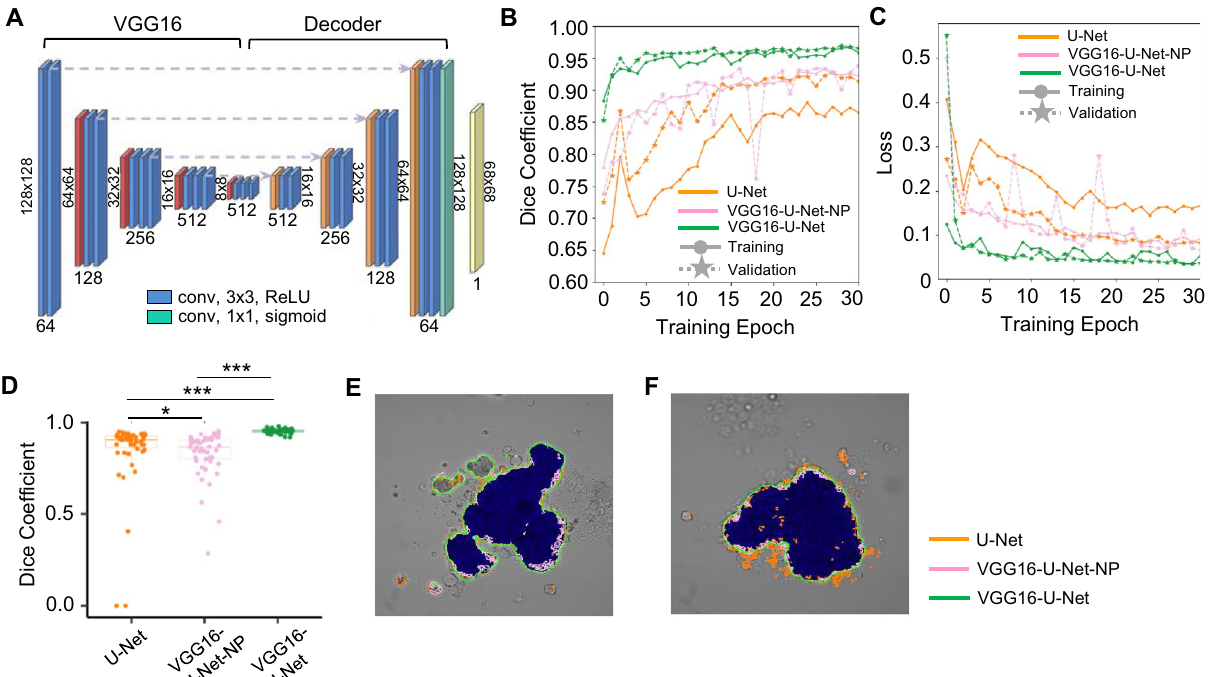
Figure 4. VGG16-U-Net-based image segmentation of VSMC spheroid morphology. ( A ) VGG16-U- Net structure. The training and validation curves of the Dice coefficient ( B ) and the loss function ( C ). ( D ) Comparison of the Dice coefficients among U-Net, VGG16-U-Net-NP, and VGG16-U-Net. * p = 0.015 and *** p < 10 –14 . The p-value was calculated by the Wilcoxon rank sum test. ( E , F ) The edges of the spheroid images were identified by U-Net, VGG16-U-Net-NP, and VGG16-U-Net. The blue regions represent the manually labeled ground-truth community detection algorithm, to produce the clustering outcomes of different numbers of clusters in the training set. We calculated the quality of each clustering result by evaluating the silhouette value, which is a measure of how similar the morphology of a given spheroid is to its own cluster compared to other clusters. We chose four as the number of clusters based on the maximum silhouette values for the number of nearest samples (Fig. 5B). Then, we performed the same clustering analysis for the testing set using the same number of clusters. The silhouette plot of the final clustering analysis showed the least overlap between clusters and mostly positive silhouette values (Fig. 5C). The distribution of spheroid morphologies in each cluster is displayed on a UMAP plot (Fig. 5D), and the proportion of spheroids in each cluster for a given drug treatment is shown in Fig. 5E. Cluster #1 has stereotypical morphologies of unperturbed circular spheroids (Fig. 5D, inset). Clusters #2 and #4 are noncircular and dispersed or disrupted. In Cluster #3, the images showed small circular shapes but contained more than one spheroid. Analysis of clustering with the training set gave similar results to the testing set (Fig. S3A,B). Furthermore, the robustness of the clustering results was tested by repeating the clustering 100 times using 100 different random splits of the training and testing datasets. We counted the cluster assignments of individual spheroid images from the repeated clustering, and assigned the majority cluster labels to them. Then we compared the majority cluster labels with the cluster labels of spheroid images in each clustering. As demonstrated in Fig. S3C, the cluster assignments were highly consistent (Cluster #1: 99.76%, Cluster #2: 97.24%, Cluster #3: 99.63%, Cluster #4: 96.57%). Also, clustering of the entire dataset without the data splitting exhibited similar results (Fig. S4). Different drug treatments produce spheroid subpopulations with different morphology pro‑ files. For DMSO-treated controls, most (approximately 70%) were in Cluster (or Type) #1 (Fig. 5E), as were human VSMC spheroids treated with the lower inhibitor concentrations (5 or 10 µM Rac and Rho inhibitors, Fig. 5E). These results indicated that VSMC spheroids in this cluster maintained unperturbed circular morphol- ogy or had minimal effects with DMSO or lower concentrations of Rac and Rho inhibitors. In contrast, the proportion of human VSMC spheroids treated with 10 μM FAK inhibitor was reduced to 10% in Cluster #1 and increased up to approximately 50% Type 2 and 40% Type 4 (Fig. 5E). High-dose (20 μM) treatment with a Rac inhibitor produced spheroids that were 50% Type 2 and 25% Type 4. A high dose (20 μM) of a Rho inhibitor led to the production of spheroids that are 20% Type 2 and 70% Type 4, which are significantly fewer than and more than those for FAK and Rac inhibition, respectively. Interestingly, treatment with 5 and 10 μM Cdc42 inhibi- tor created spheroids that are approximately 80% Type 3. Although the spheroids in Type 3 showed circular morphologies, each culture contained multiple small spheroids. In the cultures in which FAK and Rac (20 μM) were inhibited, the spheroids were mostly Types 2 and 4 (noncircular and dispersed/disrupted, respectively),